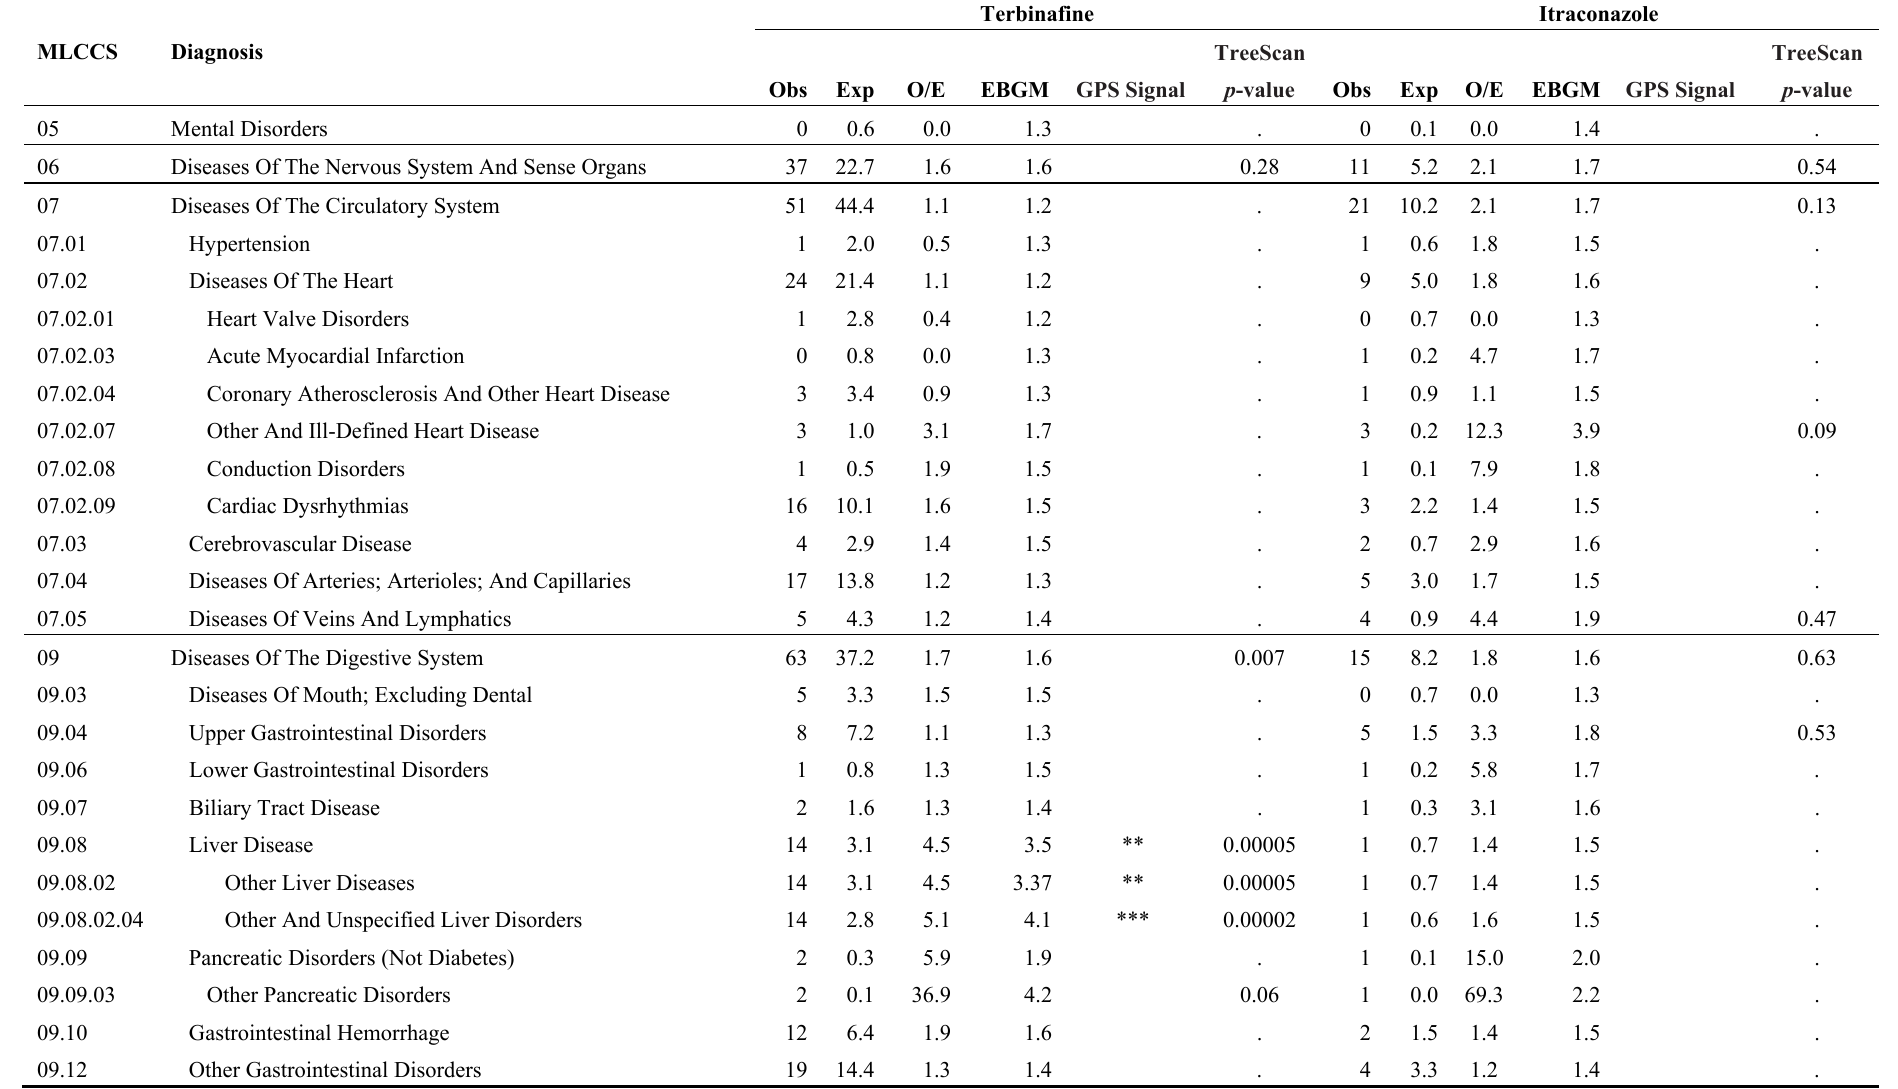
Table 2. Results for terbinafine and